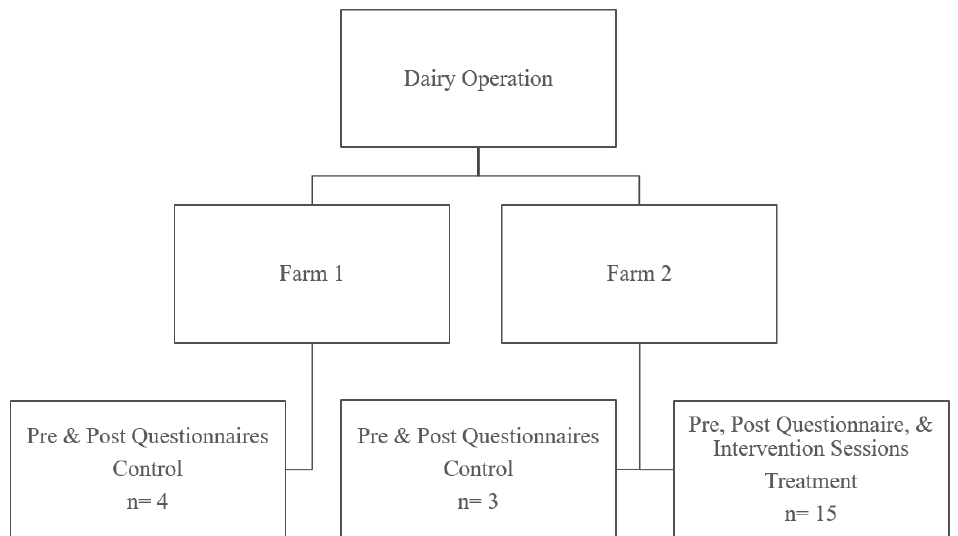
Figure 1. Flowchart identifying study population and treatment allocation. It is common for one dairy operation to have multiple farm sites.